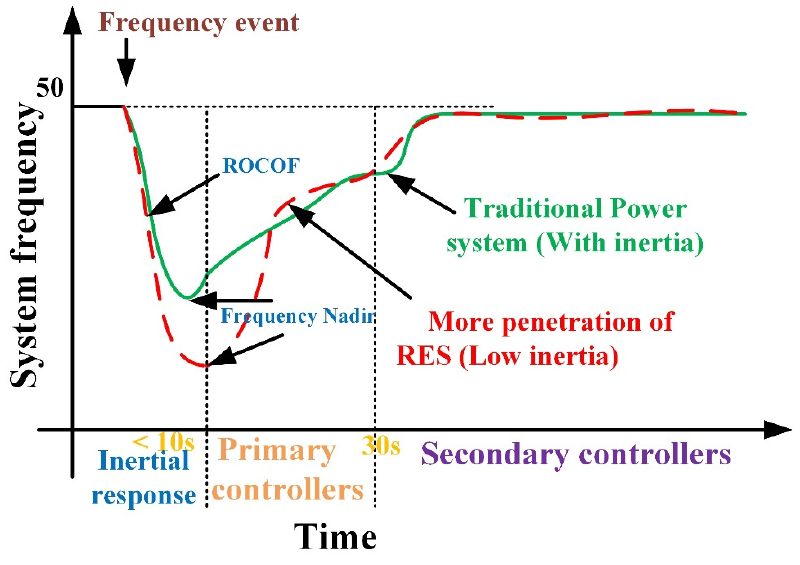
Figure 1. Various time frames for frequency control